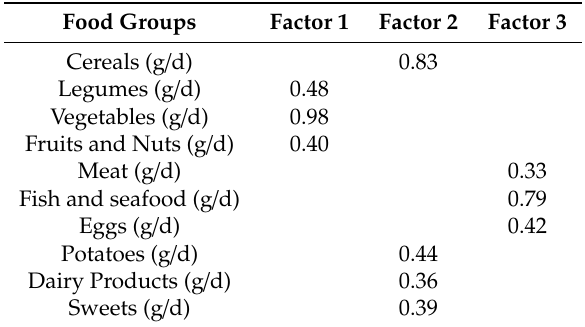
Figure 1. A Scree Plot of the 11 food groups showing the eigenvalues on the y-axis and the number of factors on the x-axis. Table 3. Varimax rotated factor loadings for the three factors of the 10 food groups derived from the food frequency questionnaire.